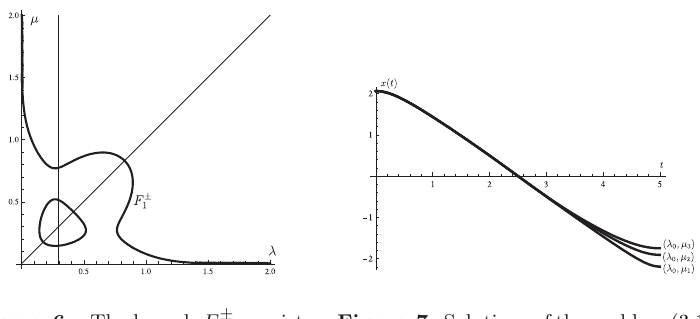
Figure 7. Solutions of the problem (3.1), f = g, a = 0 , b = 5 , for λ = λ 0 , µ =